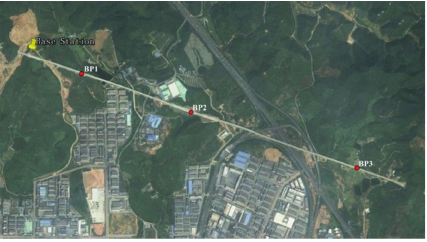
Figure 1: Aerial map of measured hilly area. The white line indicates the railway and the marker indicates the base